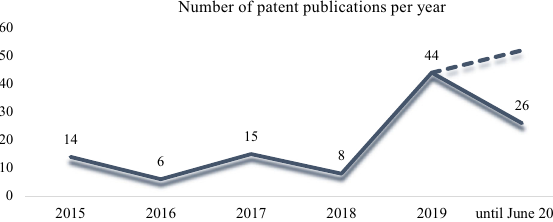
Fig. 3 Number of patent publications per year. Solid line refers to the current number of fi lled patents over time; dashed line means the estimate for 2020 by taking into consideration the increasing number recorded in the previous year and in early